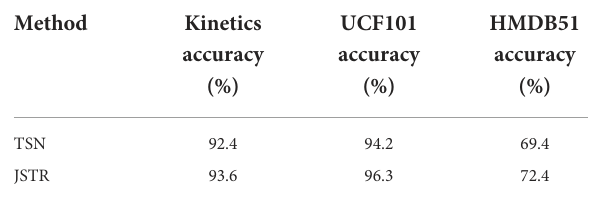
TABLE 4 Exploration of JSTR.